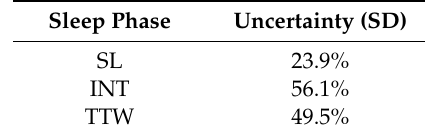
Table 5. Statistical confidence, with a coverage factor of two, correlating the PIR sensor measures with the reference sensor.